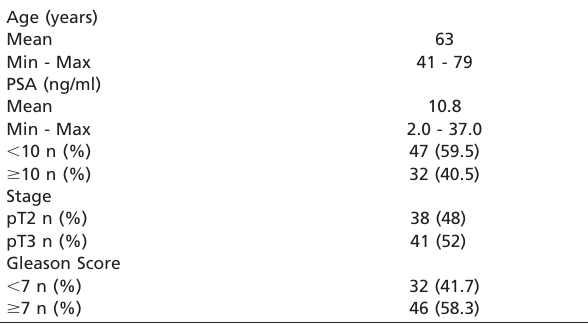
Table 1 - Age and clinical characteristics of 79 men who underwent radical prostatectomy to treat prostate